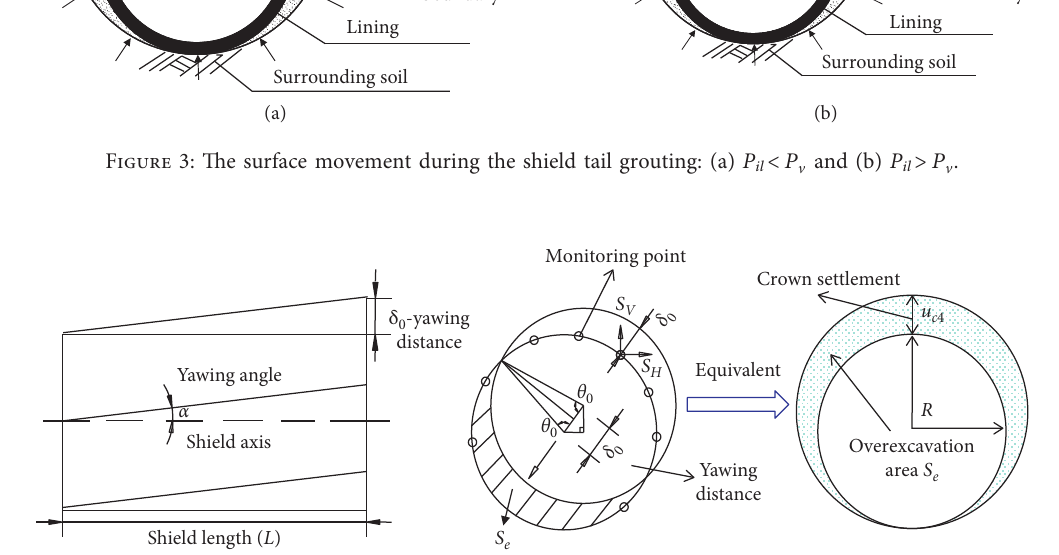
Figure 4: Tunnel vault deformation caused by shield